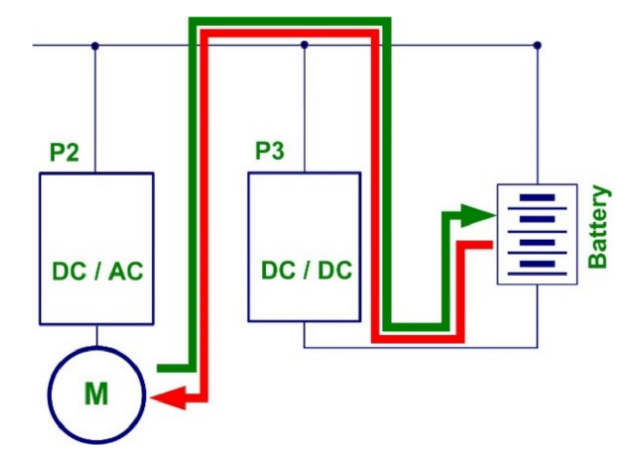
Figure 4. Diagram of power flow during the machine ride (red) and braking (green). During the ride, energy will always flow from the battery to the main motor. In the